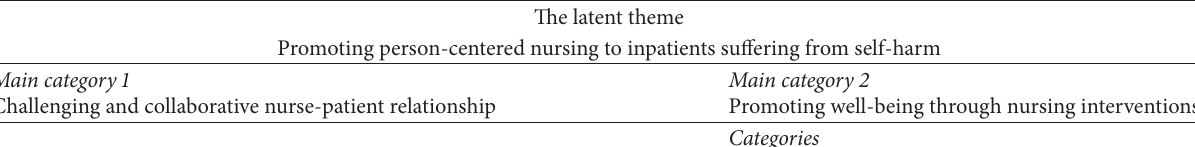
Table 2: Mental health nurses’ experiences of caring for inpatients suffering from